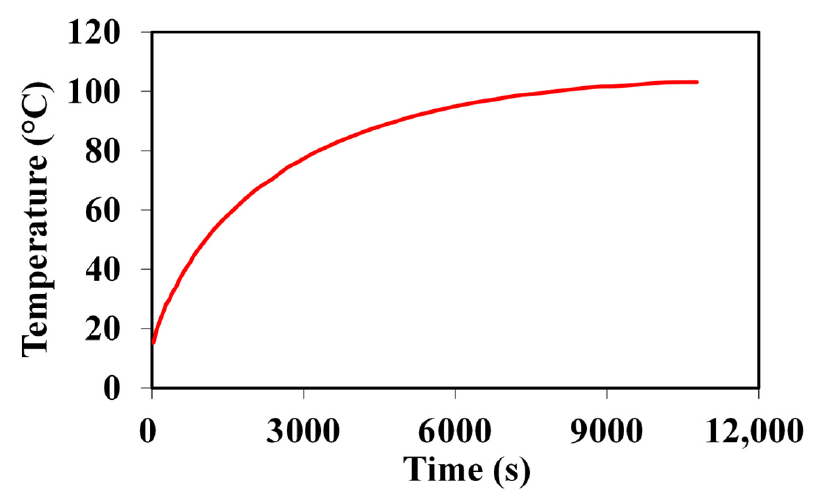
Figure 14. Transient temperature rise in winding under healthy condition.